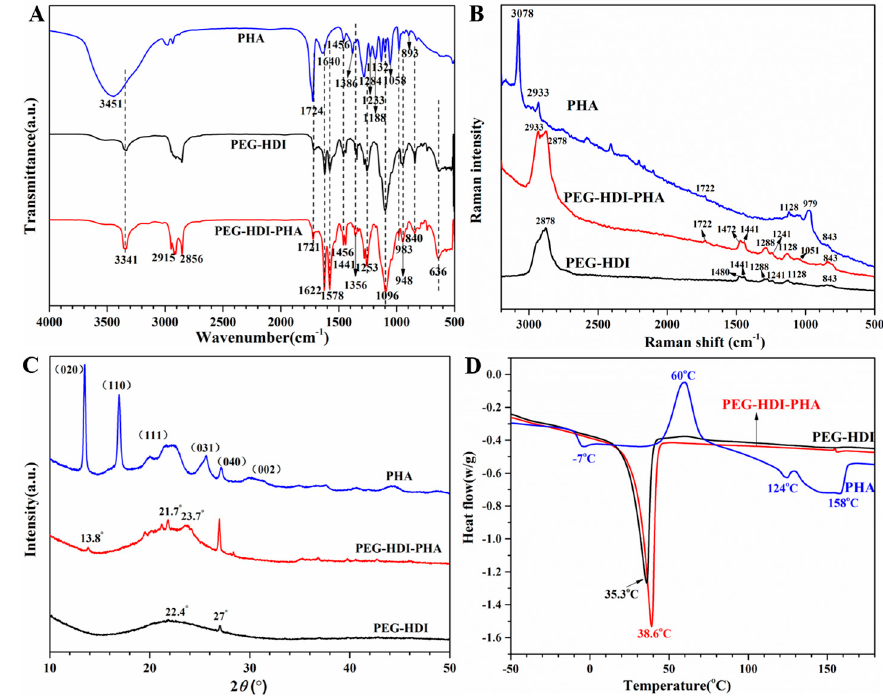
Figure 2. Characterization of the synthesized PHA-based polyurethane: ( A ) FT-IR spectra and ( B ) Raman spectra; ( C ) XRD analysis and ( D ) the second DSC heating curves.